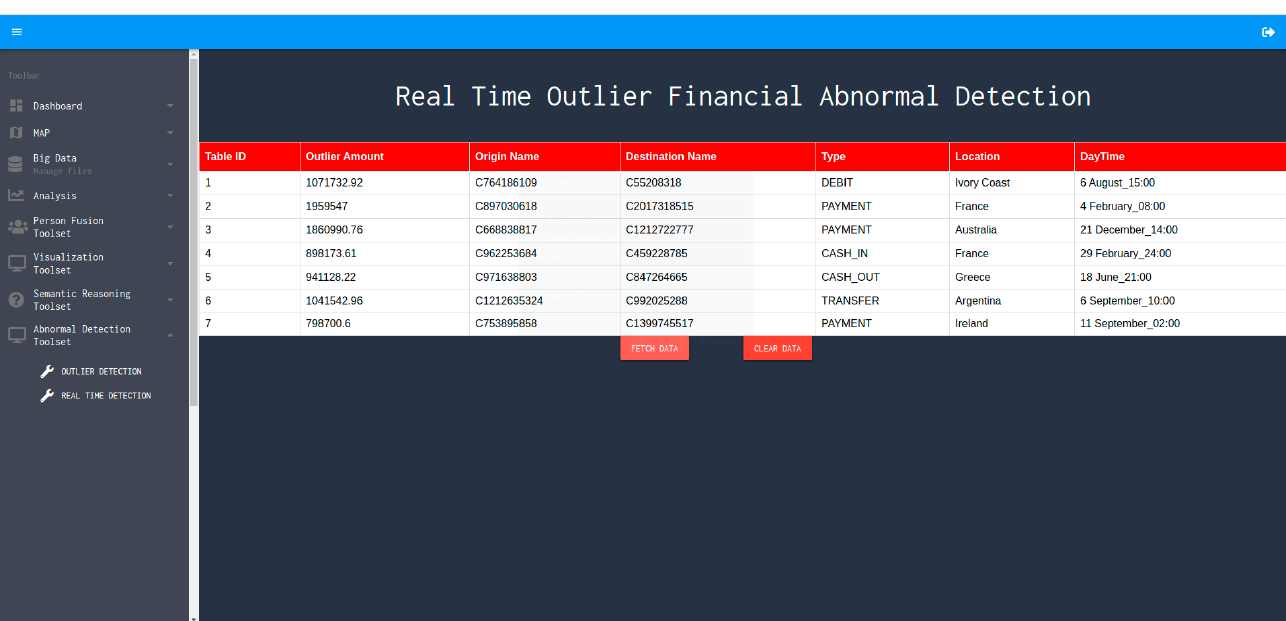
Figure 5. Real-time financial outlier detection table.